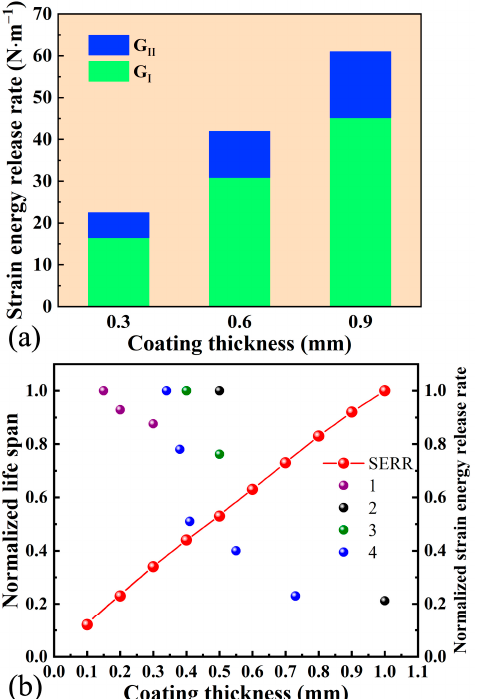
Figure 11. Effect of TC thickness on ( a ) the driving force (SERR) of cracking and ( b ) TBC life span and normalized SERR. The experimental data were adapted from previous reports 1 [69], 2 [70], 3 [71], and 4 [57].